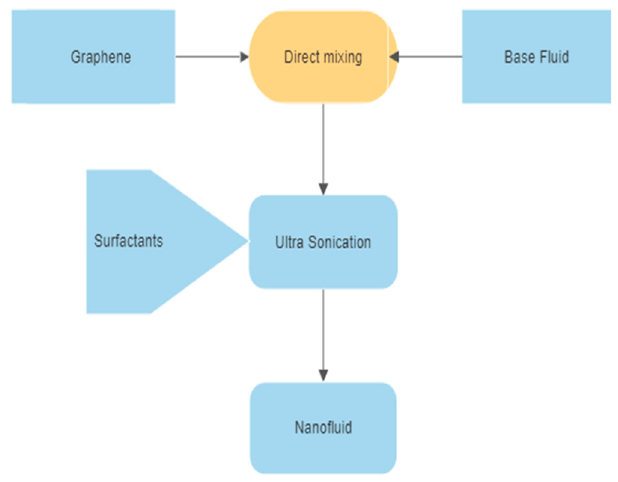
Figure 5. Non-covalent